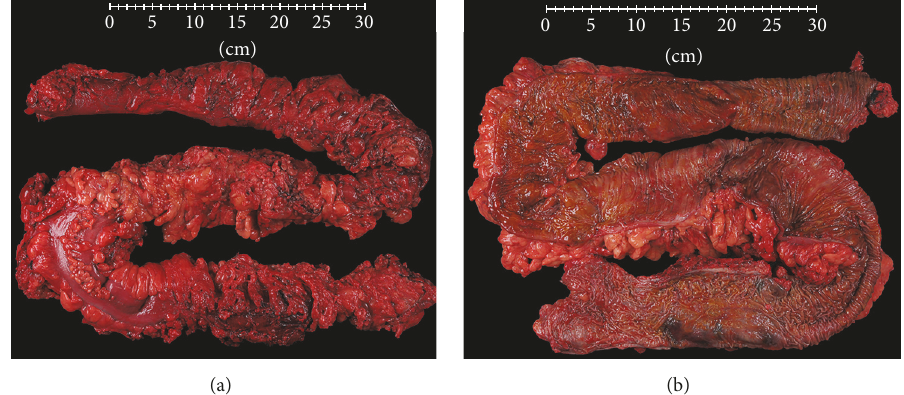
Figure 1: Gross examination of the ileocolonic surgical resection specimen revealed extensive fat wrapping and induration of the peri-ileal and pericolonic adipose tissue (a). Examination of the mucosal surface was relatively unremarkable without evidence of strictures, fistulae, or mucosal ulcers (b).